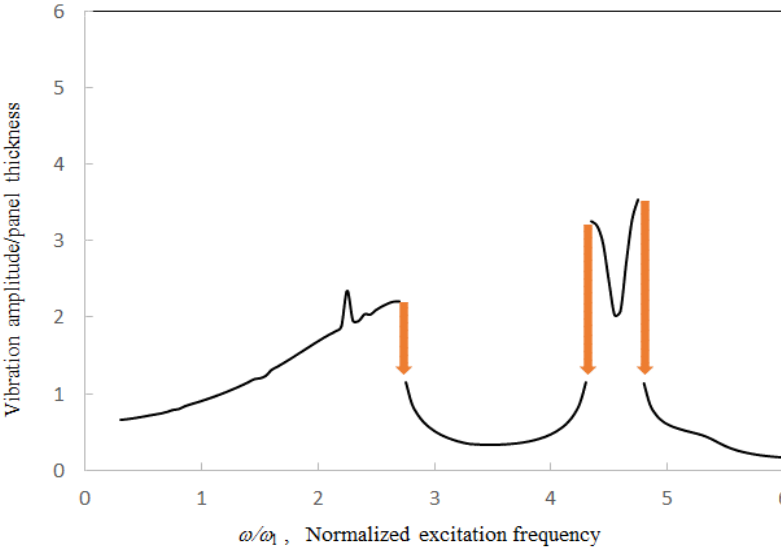
Figure 13. Vibration amplitude ratio versus normalized excitation frequency for various acoustic boundary conditions (number of structural modes = 2, number of acoustic modes = 4, γ = 2, θ = 8, l = 5 a ; the orange arrows represent the “jump phenomenon”).